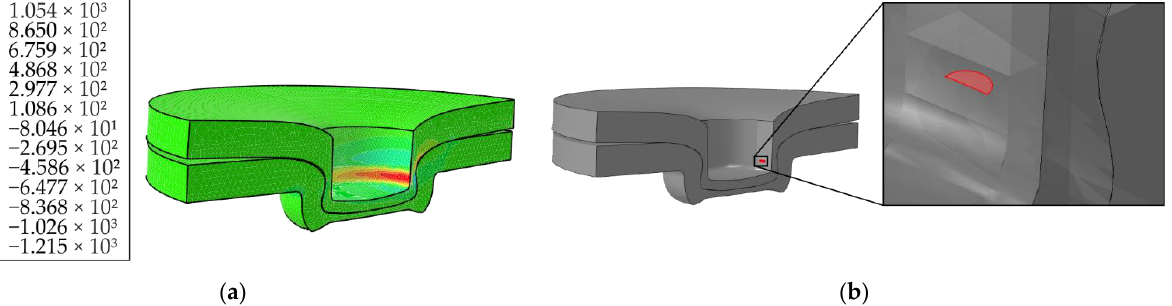
Figure 4. Simulation results of the clinched joints and initial crack: ( a ) The maximum principal stress distribution in the clinched joints; ( b ) The initial semi-circular crack at the location with the maximum value for principal normal stress.